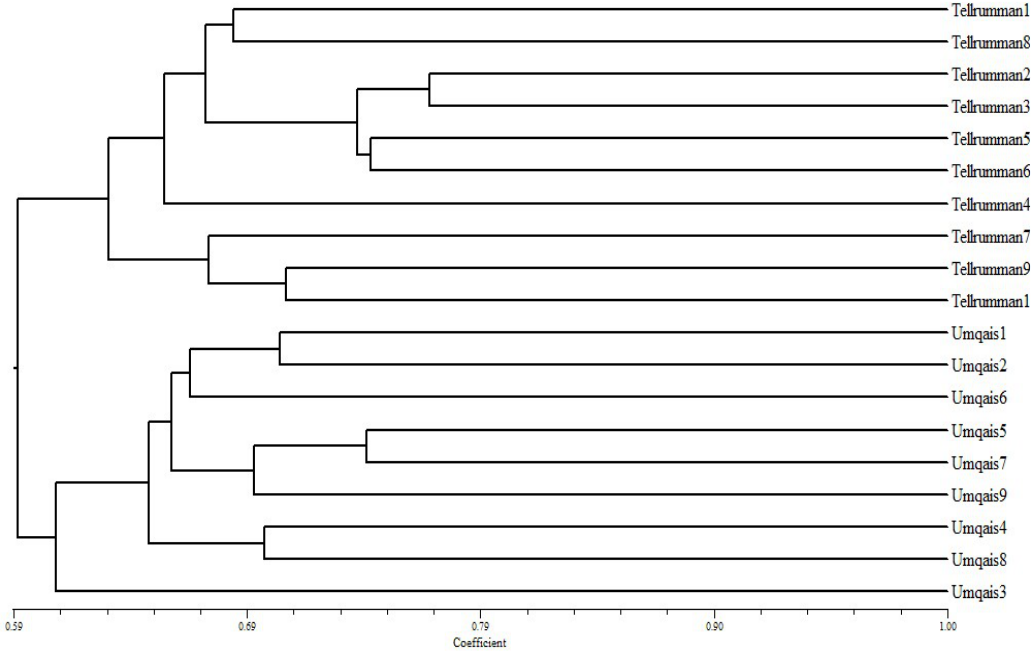
Figure 4. A dendrogram showing relationships among 19 Jordanian Pleurotus isolates by using ISSR markers data and the Dice genetic similarity and the Un-weighted pair group method with arithmetic average (UPGMA) clustering method.